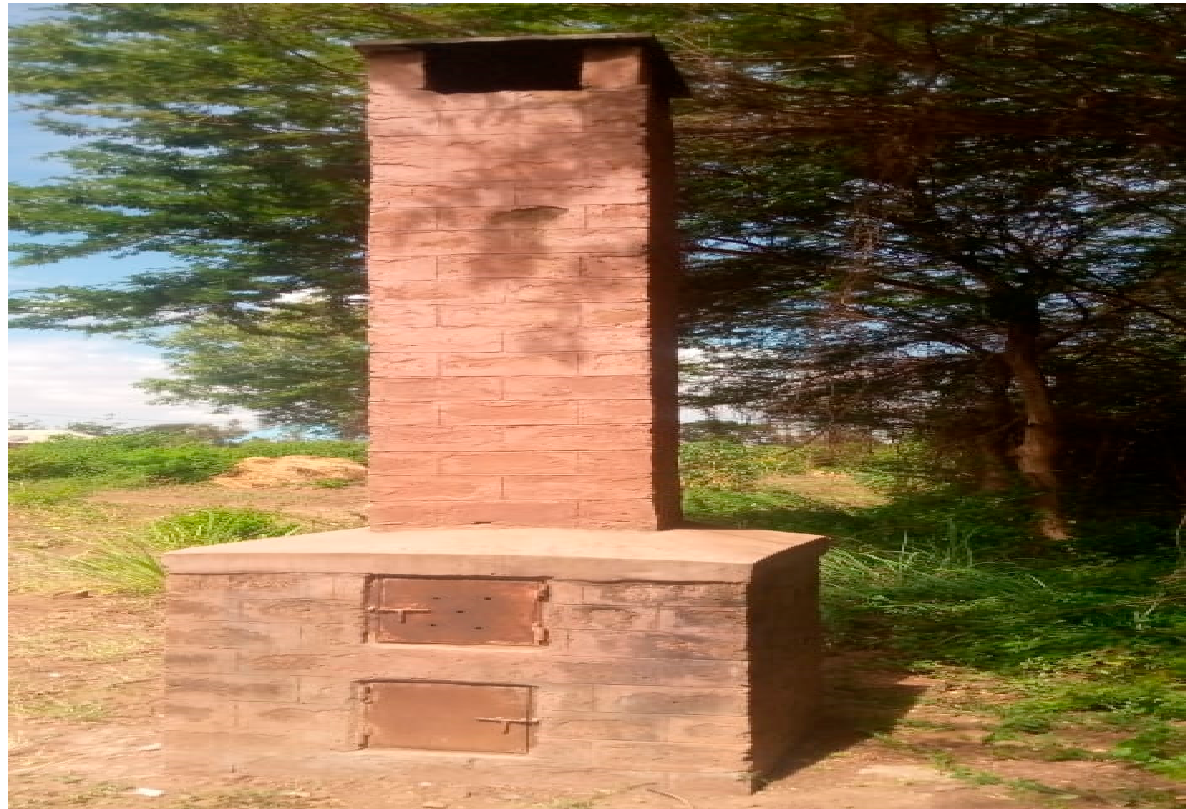
Figure 6. A locally constructed incinerator at KCMUCo ‐ PAMVERC.